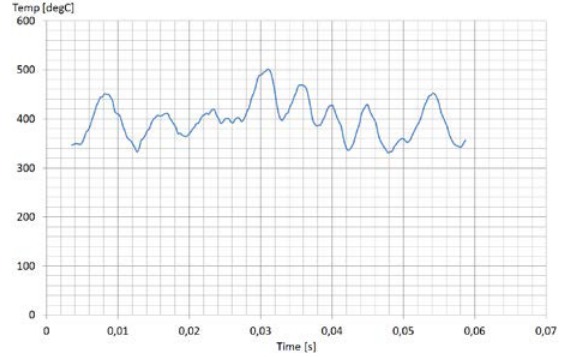
Fig. 9. The actual temperature sensor signal